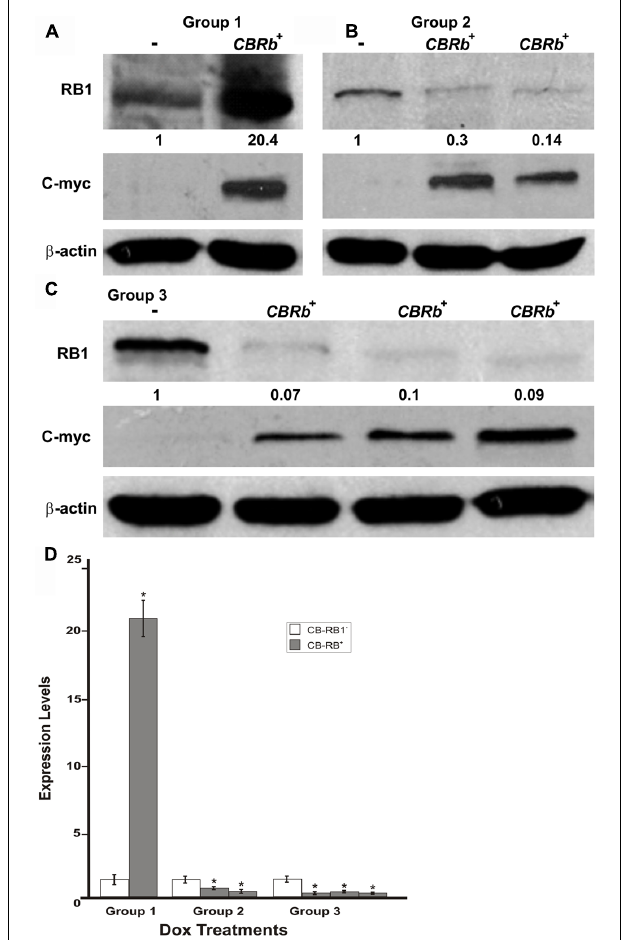
FIGURE 7 | DN-CBRb transgene activation in the inner ear of postnatal (P) 36 DN-CBRb + / ROSA-CAG-rtTA + (CBRb + ) and DN-CBRb − / ROSA-CAG-rtTA + (CBRb − ) mice after 3 (group 1), 7 (group 2), and 10 (group 3) days of Dox treatment. (A–C) Anti-RB1, which reacts with both hyperphosphorylated and hypophosphorylated forms of RB1, as well as anti-c-myc antibodies were used for detection. Densitometric analysis was done using ImageJ software (http://imagej.nih.gov/ij/).The corresponding values obtained were normalized to the negative control CBRb ( − ) and then to β -actin.The relative RB1 expression levels are shown underneath each blot. (D) Graphic representation of normalized RB1 expression levels plotted against the different treatments highlights a consistently lower RB1 detection in CBRb + samples. Each lane on the Western blot gel (A–C) and each column on the graphic (D) correspond to a different individual and sample. ( − ) = CBRb − ; * P < 0.05.